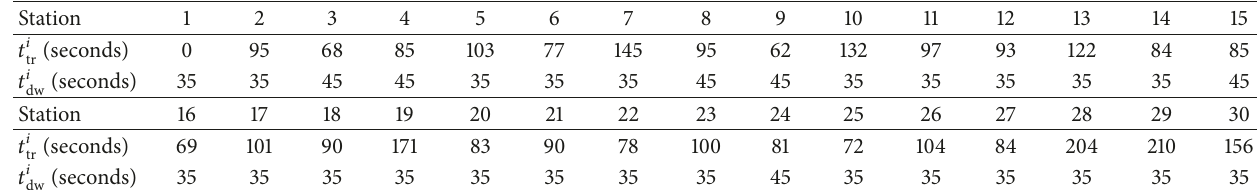
Table 2: Train operation